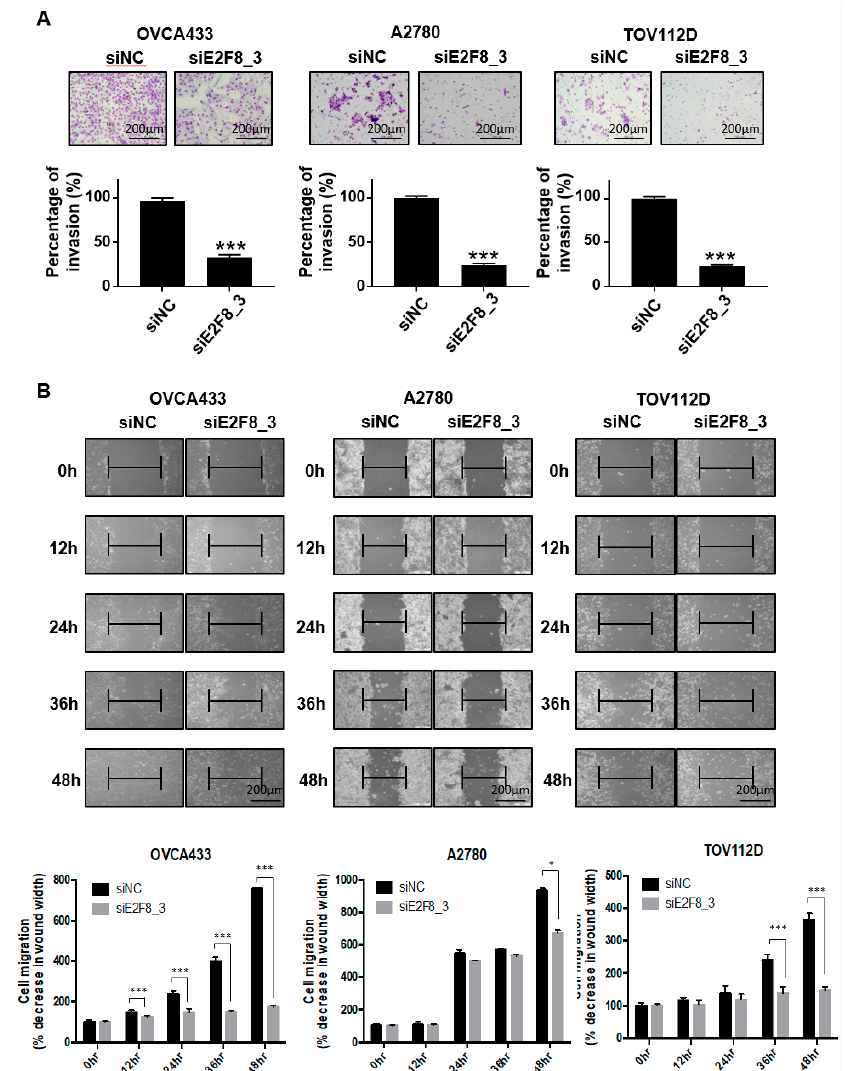
Figure 3. Knockdown of E2F8 inhibits the invasion and migration of OVCA433, A2780, and TOV112D cells. ( A ) Matrigel invasion assay was used to determine invasion after 48 h. ( B ) Wound-healing assay was used to determine migration in siE2F8-transfected OVCA433, A2780, and TOV112D cells (×200). This assay was performed in triplicate. Data are the mean ± SD. * p < 0.05, *** p < 0.001 vs. negative control siRNA [negative control siRNA (siNC)].